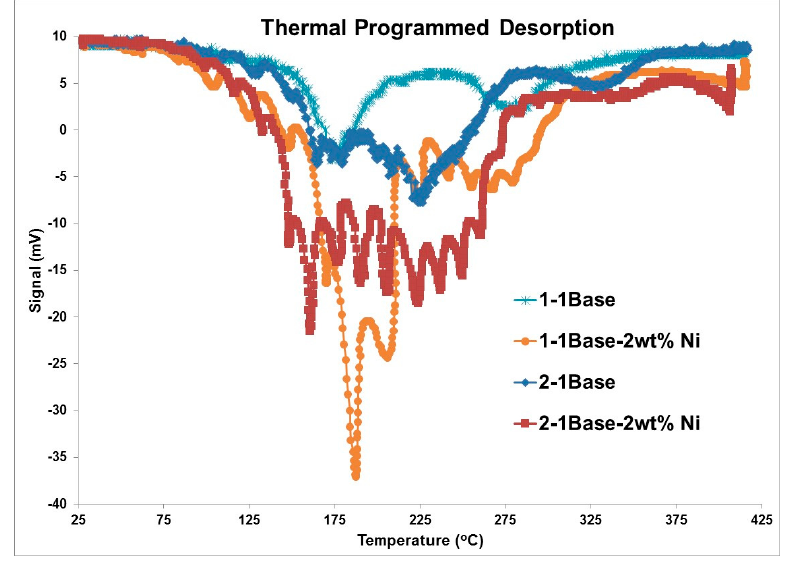
Figure 2. Thermal programmed desorption (TPD) profiles of pristine and 2 wt. % nanoNi-doped LiNH 2 -nanoMgH 2 with 1:1 and 2:1 ratios.